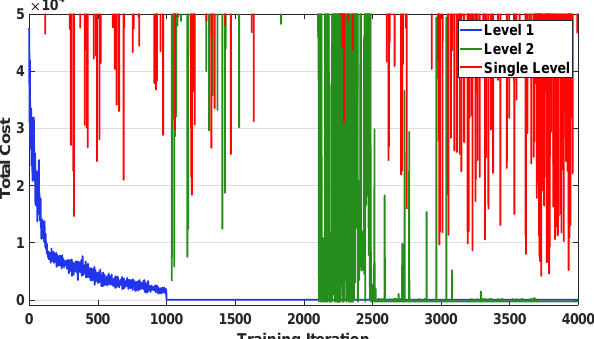
Figure 10. Comparison of the total cost convergence between the proposed two-level DRL approach and the single-level DRL approach.